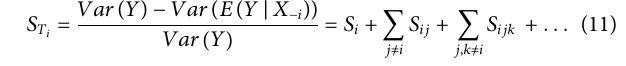
Figure 6B. A α y cut is obtained by fi xing the CDF to a certain value y